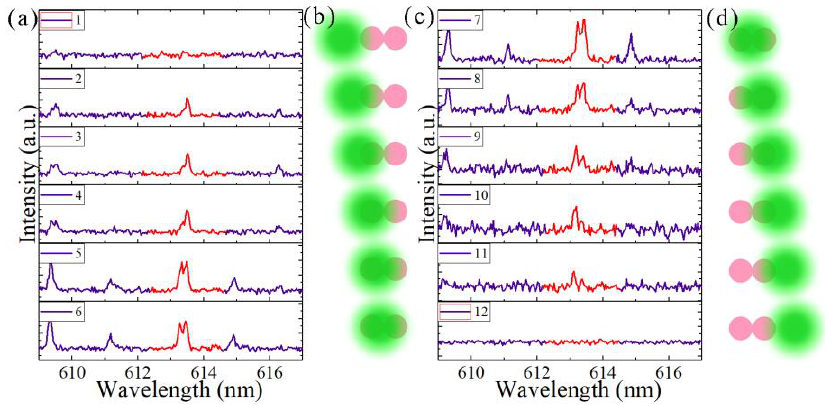
Figure 7. Laser spectra from different positions of the pump beam spot. ( a ) and ( c ) spectra during the moving of the pump laser from left to right. ( b ) and ( d ) schematics of the position of the pump beam spot.